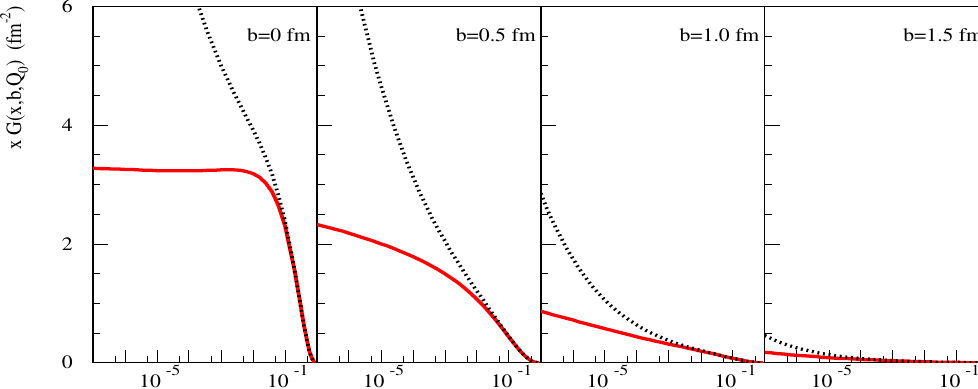
) at the Q 2 scale for different values of b (as indicated in 0 0 = 1 GeV 2 - solid lines. x G ( x , (cid:126) b , Q 2 ) calculated g / p 0 0